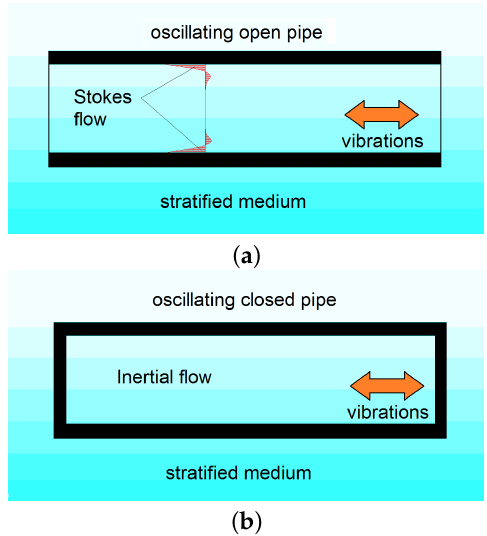
Figure 1. Comparison of two fundamentally different situations: ( a ) an oscillatory excitation comes from a surface force (for example, as in Stokes problem [19]); ( b ) an oscillatory excitation is caused by an inertial force acting in the bulk of a fluid (as in the present